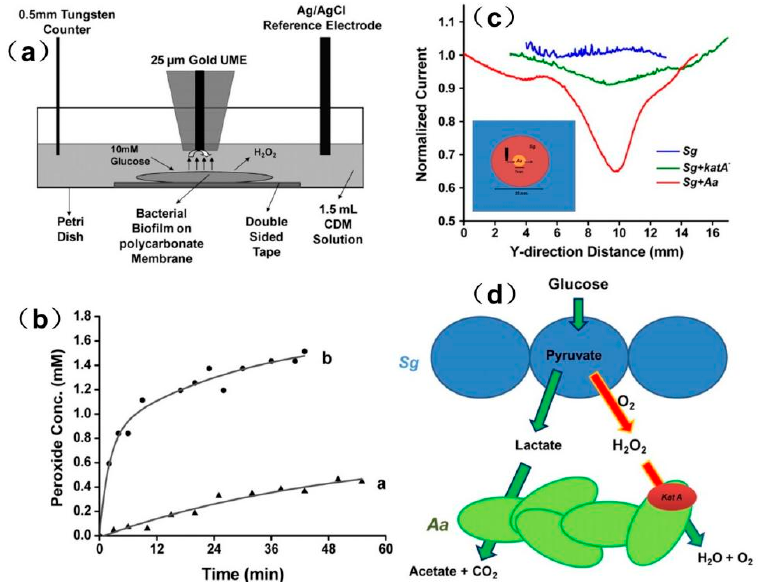
Figure 17. ( a ) Schematic diagram of an electrochemical experimental setup for the real-time measurement of hydrogen peroxide formation in a bacterial biofilm; ( b ) Plots of the concentrations of hydrogen peroxide produced by Streptococcus gordonii (Sg) in biofilm as a function of time at different distances between the Au UME and the biofilm ( a , 200 µ m, b , 100 µ m); ( c ) Normalized current changes of an SECM y-scan over Sg alone, mutant Aggregatibacter actinomycetemcomitans (Aa) in an Sg film, and wild-type Aa in an Sg film, respectively. Inset is the schematic diagram of a tip scan across the region of a mixed species biofilm in the order of Sg–Aa–Sg; ( d ) Model for the role of hydrogen peroxide in an Sg and Aa co-cultured biofilm. Copyright (2011) National Academy of Sciences.